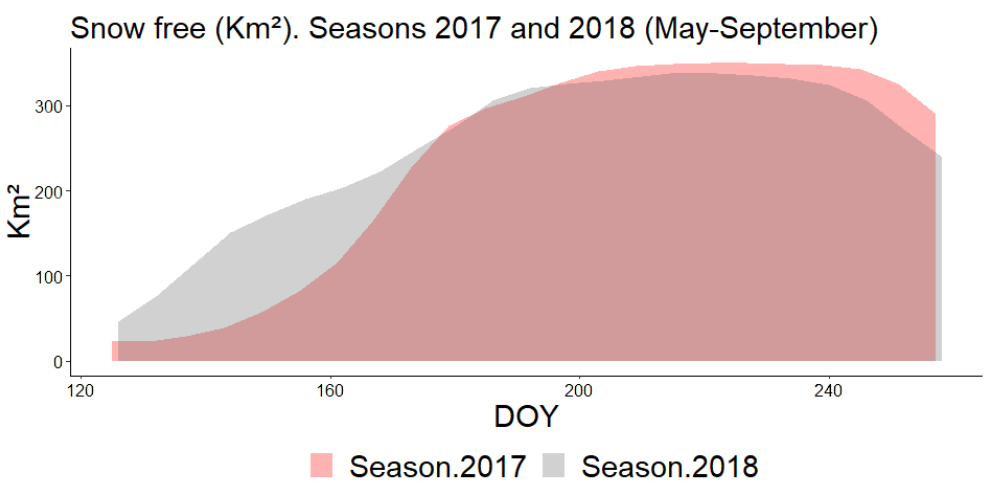
Figure 7. Surface [km 2 ] free of snow during the season 2017 and